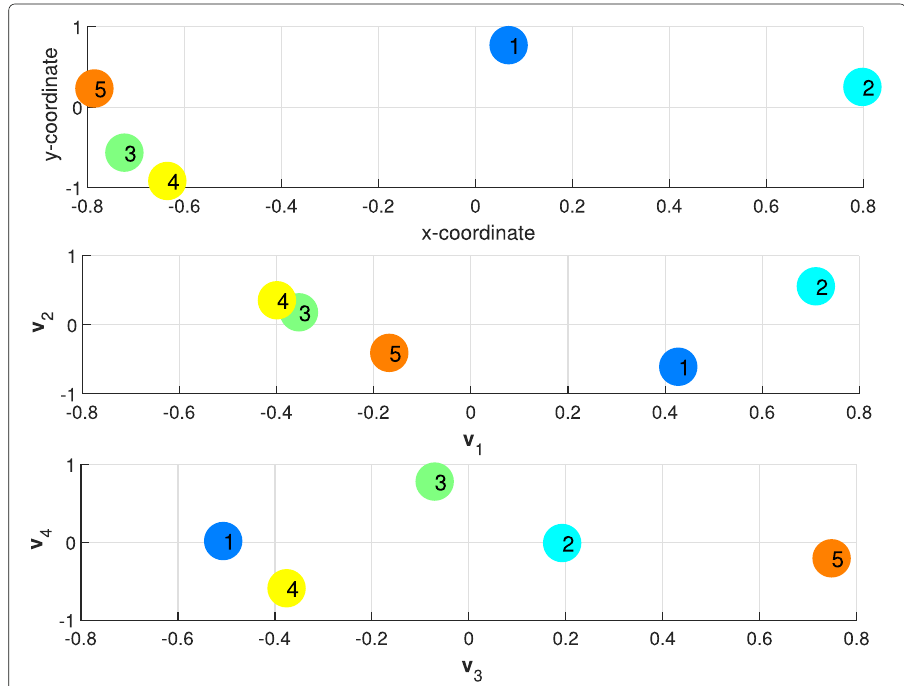
Fig. 2 A connected graph of five nodes. Top: two-dimensional true location of the nodes. Middle: LE logical location of the nodes using the first and second Eigenvectors. Bottom: logical location using the third and fourth